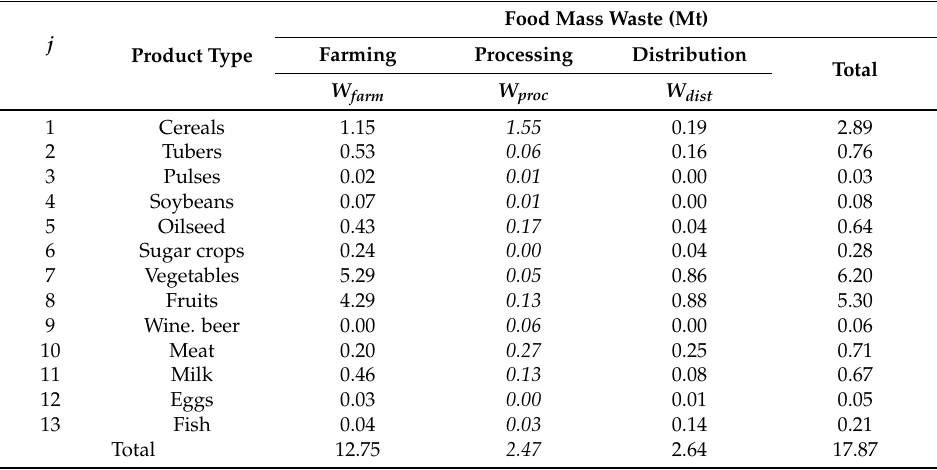
Table A3. Masses of food losses and waste at different steps of the FSC.